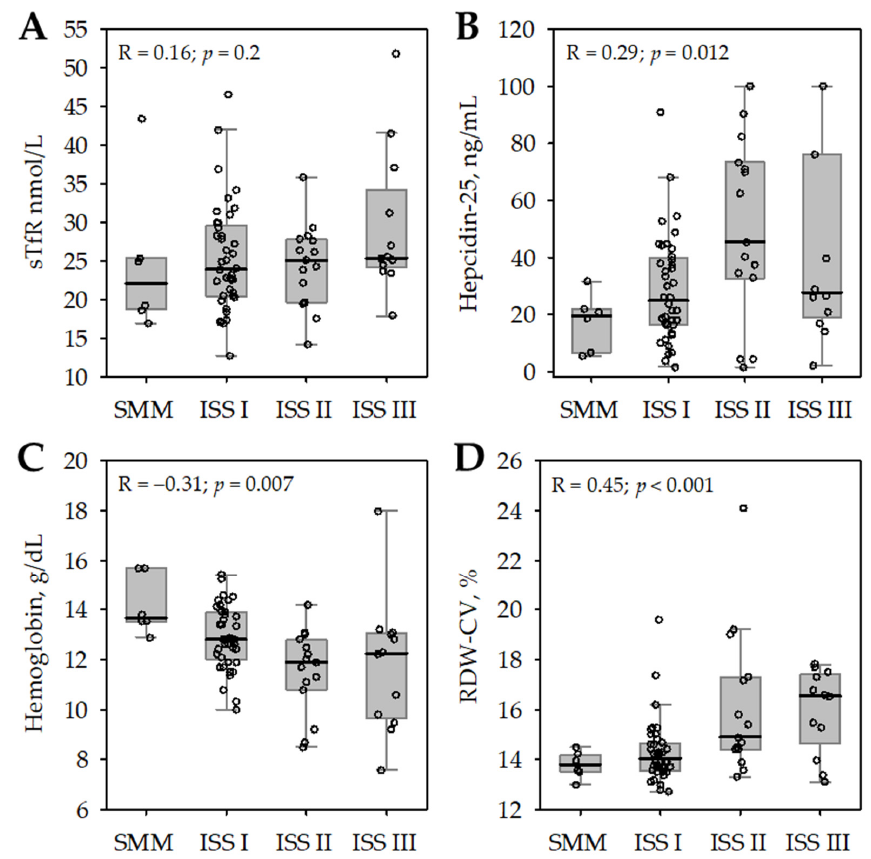
Figure 2. Soluble transferrin receptor (sTfR, A ), hepcidin-25 ( B ), blood hemoglobin ( C ), and red cell distribution width–coefficient of variation (RDW-CV, ( D )), among 73 studied patients with multiple myeloma (MM) according to increasing stage of the disease: from smoldering multiple myeloma (SMM) to International Staging System for MM (ISS) stage III. The data are shown as median (central line), interquartile range (box), non-outlier range (whiskers), and outliers (points). Spearman correlation coefficients (R) and p -values describe the correlations of the studied variables (shown on the Y -axis) with ordered scale of increasing severity of MM (from SMM to ISS stage III MM, as shown on the X -axis).